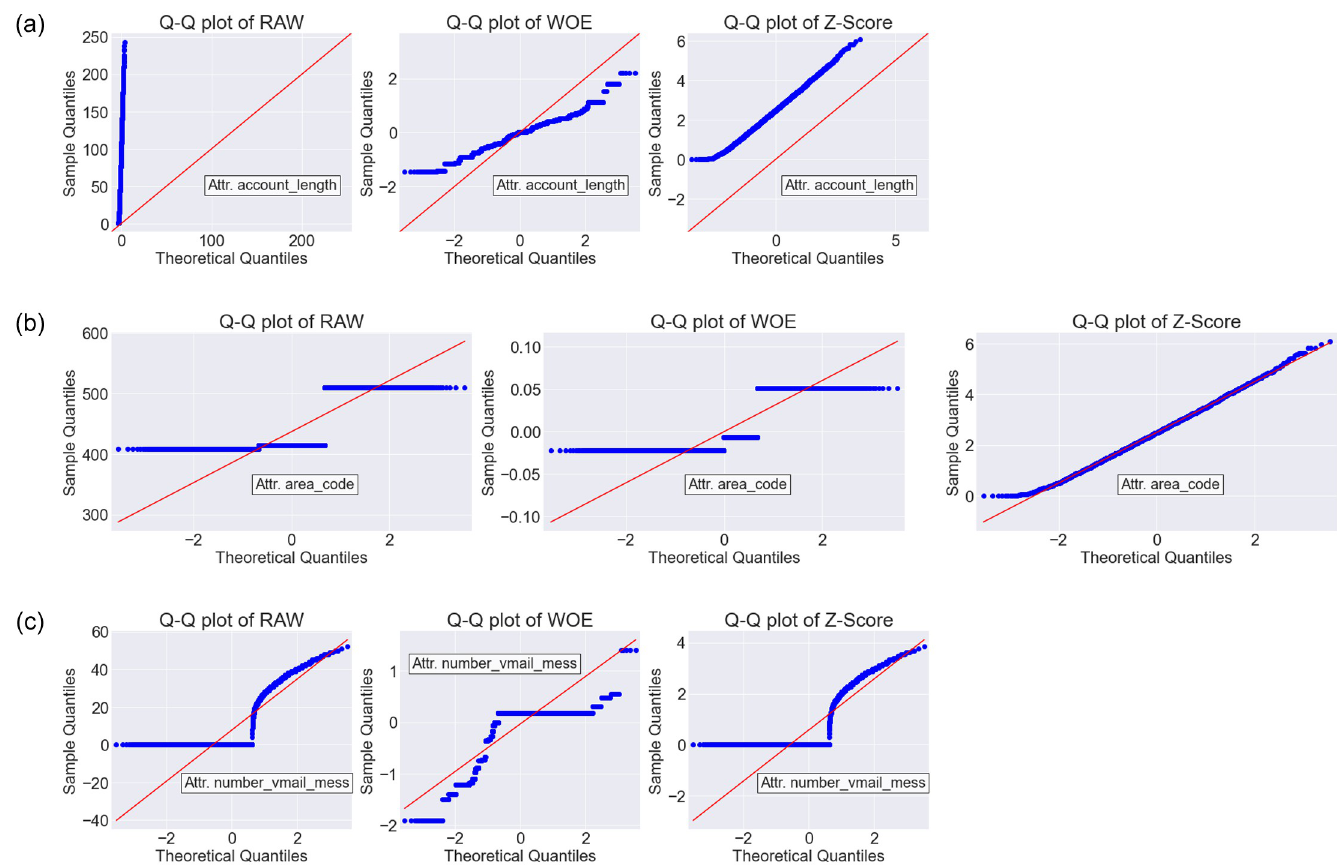
Fig 6. The Q-Q plot forRAW (without DT), WOE and Z-Score DT methods on